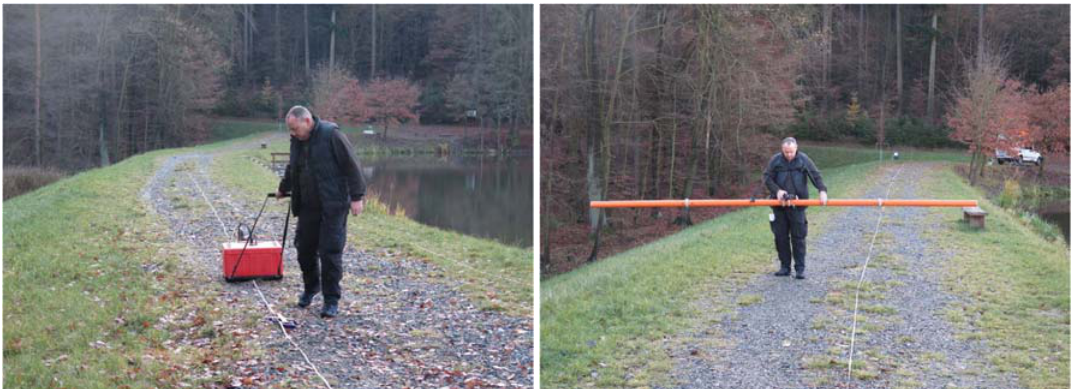
Figure 2. Geophysical survey with ground penetrating radar ( left ) and dipole electromagnetic meter ( right